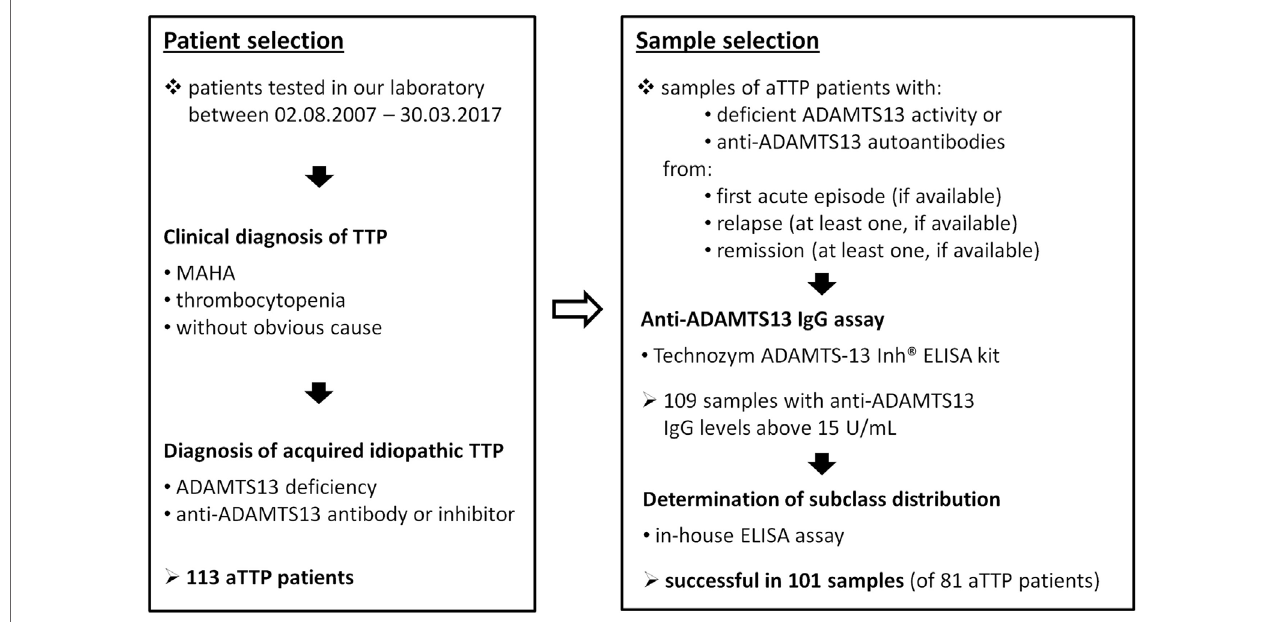
FigUre 1 | Scheme of patient and sample selection. Abbreviations: MAHA, microangiopathic hemolytic anemia; aTTP, acquired idiopathic thrombotic thrombocytopenic